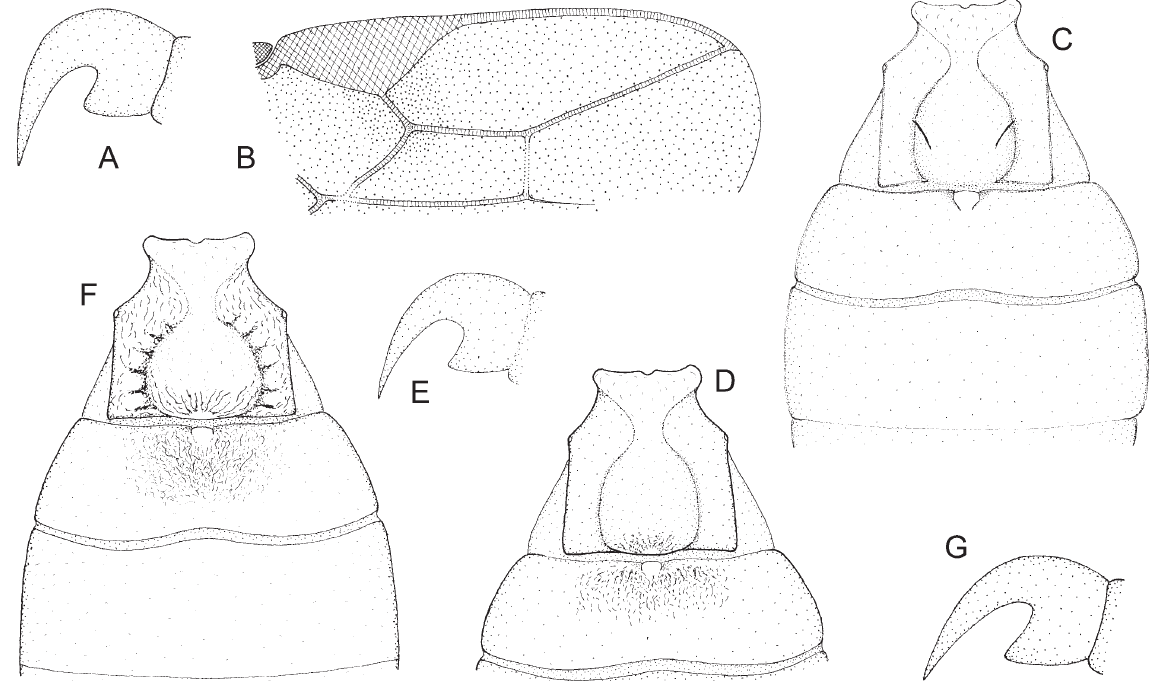
Fig. 50. — A-B. Bracon ( Glabrobracon ) terebella Wesmael, 1838 (A: ♀ lectotype, B: ♀ /